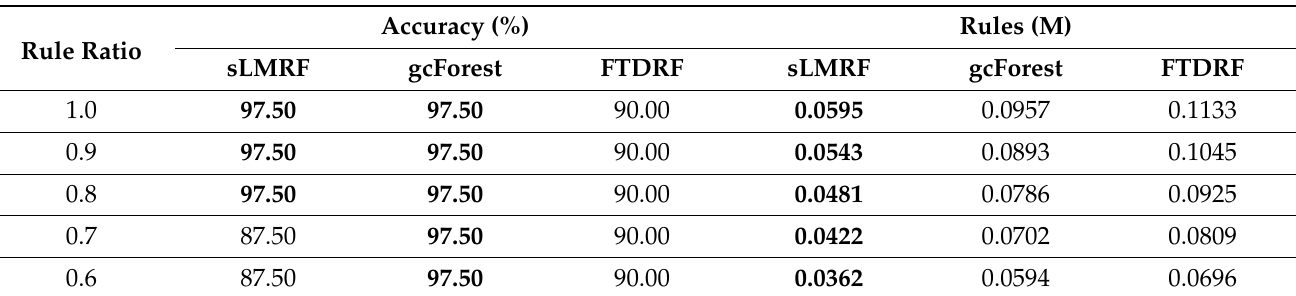
Table 5. Comparison of accuracy and numbers of rules among three DRF models according to changes in rule elimination using the ORL dataset. The rule ratio 1.0 of sLMRF is the same as that of